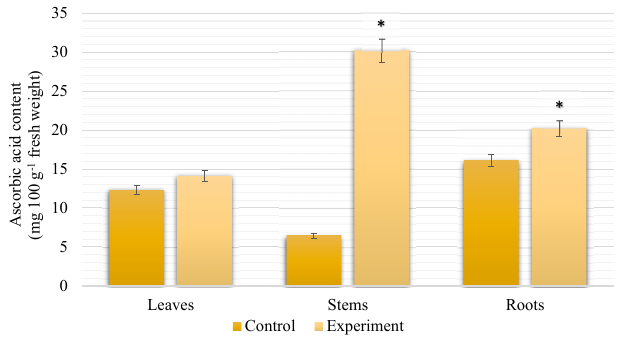
Figure 4 Content of AsA in Salix viminalis under salinity condition (field condition, 120 days of growth). * Significant difference compared with the control, p < 0.05.